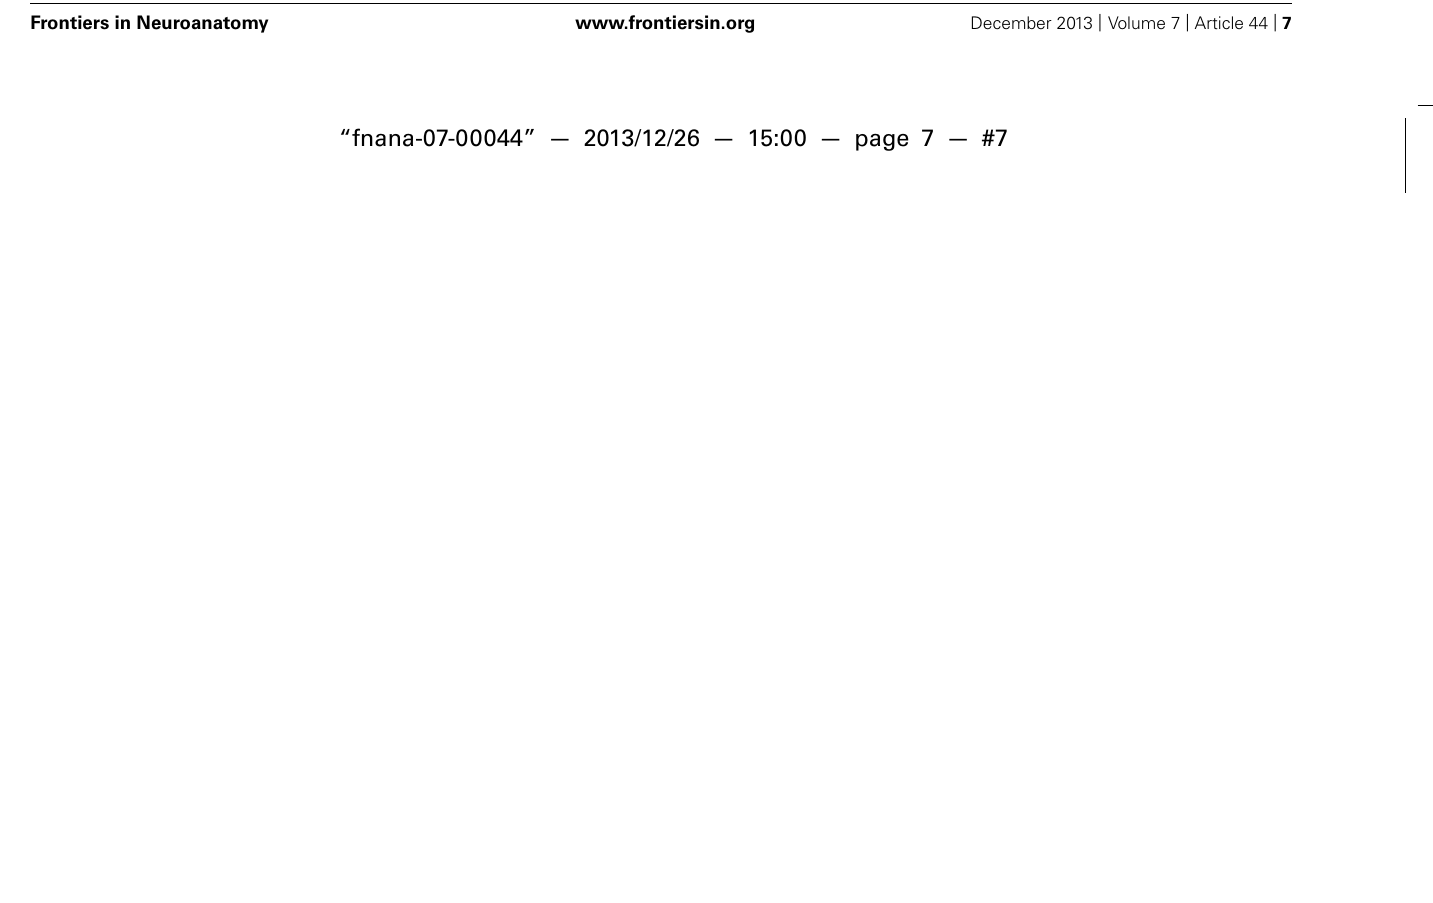
rats (D) , and C16 + CNTF-treated rats (E) . (F,G) Treatment with CNTF or C16 prevented demyelination at week 2 (F) and week 8 (G) post-immunization. a P < 0.05 versus the normal control; b P < 0.05 versus vehicle-treated EAE rats; c P < 0.05 versus CNTF-treated EAE rats; d P < 0.05 versus C16-treated EAE